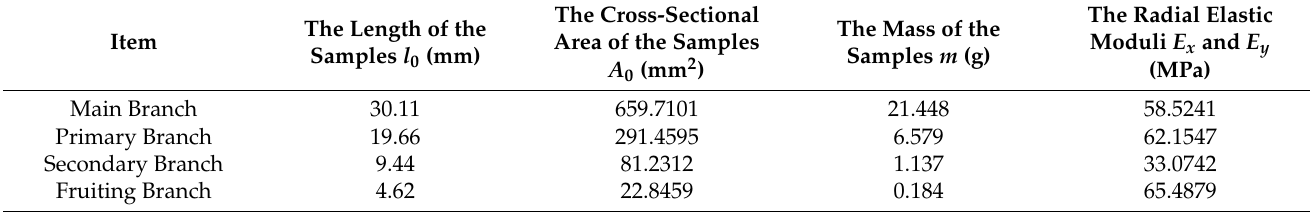
Table A1. The parameters of the branches in the radial compression tests.